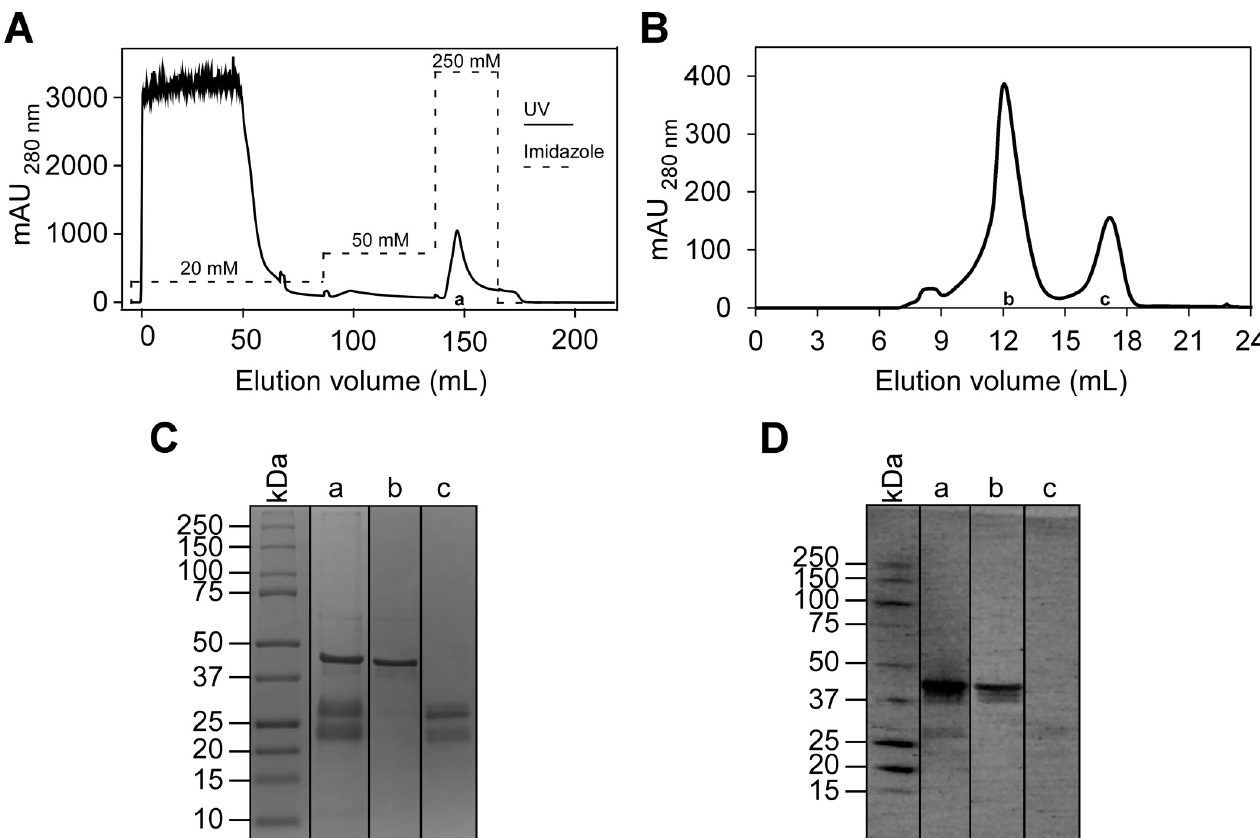
Fig 3. Purification of membrane translocated mature FopA. (A) The Ni-NTA elution profile and (B) SEC profile of FopA. (C) SDS-PAGE of FopA purification products visualized by Coomassie stain. Lane a, pooled elution fractions of FopA from Ni-NTA affinity chromatography; Lane b, pooled elution fractions of mature FopA (elution volume 10–14 mL) in SEC; lane c, pooled elution fractions of truncation products of FopA (elution volume 16–17 mL) in SEC. (D) Immunoblot using anti-FopA polyclonal antibody of the same samples as in